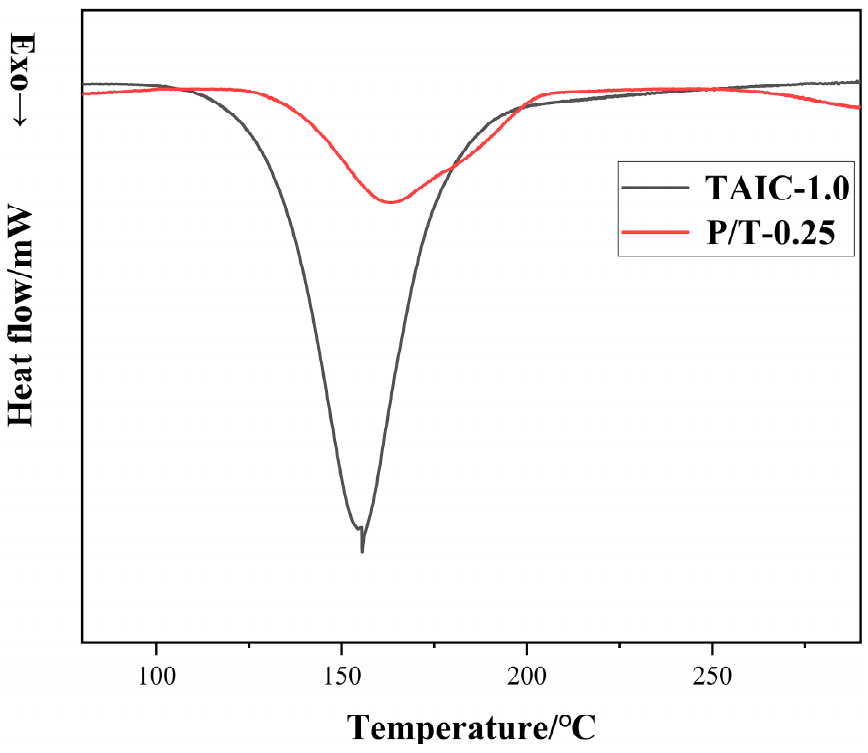
Table 7. Melt viscosity of different samples.